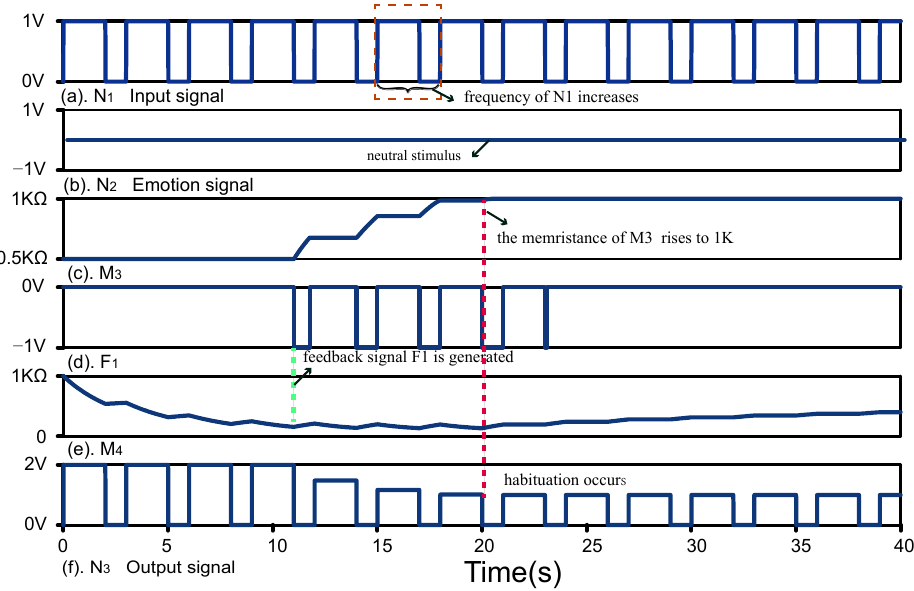
Figure 14. Frequency -dependent habituation. ( a ) Input signal. ( b ) Emotion signal. ( c ) Memristance of M 3 . ( d ) Feedback signal F 1 . ( e ) Memristance of M 4 . ( f ) Output signal N 3